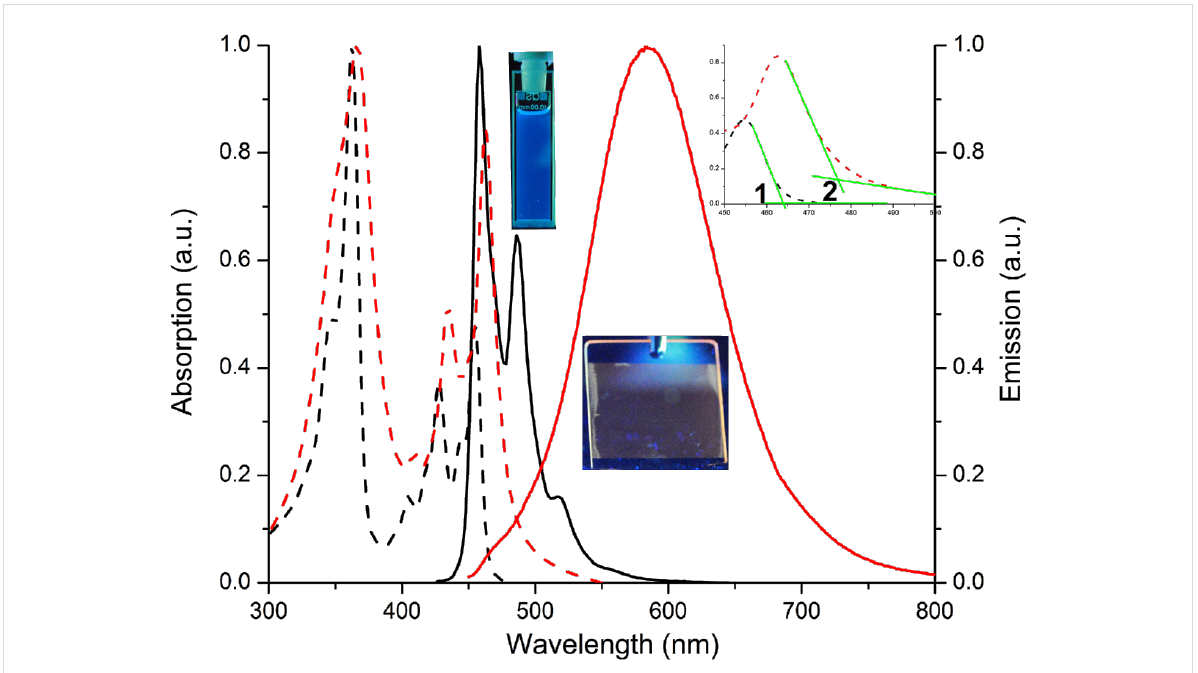
Figure 3: Absorption (dotted line) and emission spectra (solid line) of Al(Op) 3 in CH 2 Cl 2 solution (black) and as a thin film on quartz (red). In the absorption spectra, the first band, between 325 and 375 nm ( ε 362 = 90.7 × 10 3 M − 1 cm − 1 ), is associated with π→π * transitions. The second structured band, between 400 and 475 nm ( ε 454 = 43.6 × 10 3 M − 1 cm − 1 ), is attributed to n →π * transitions. In the inset the region of the first absorption band and the graphical estimation of the onset of the bands are illustrated. The onset of Al(Op) 3 in solution is 464 nm (1) and in the thin film is 476 nm (2). The respective optical HOMO–LUMO band gaps converted to eV are 2.67 eV and 2.60 eV. The emission spectra were recorded with an excitation wave- length of 350 nm. The excimer formation is clearly noticeable from the difference in the emission peaks in solution and in the thin film. Photographs of the samples under UV irradiation are included to show the visible color change.